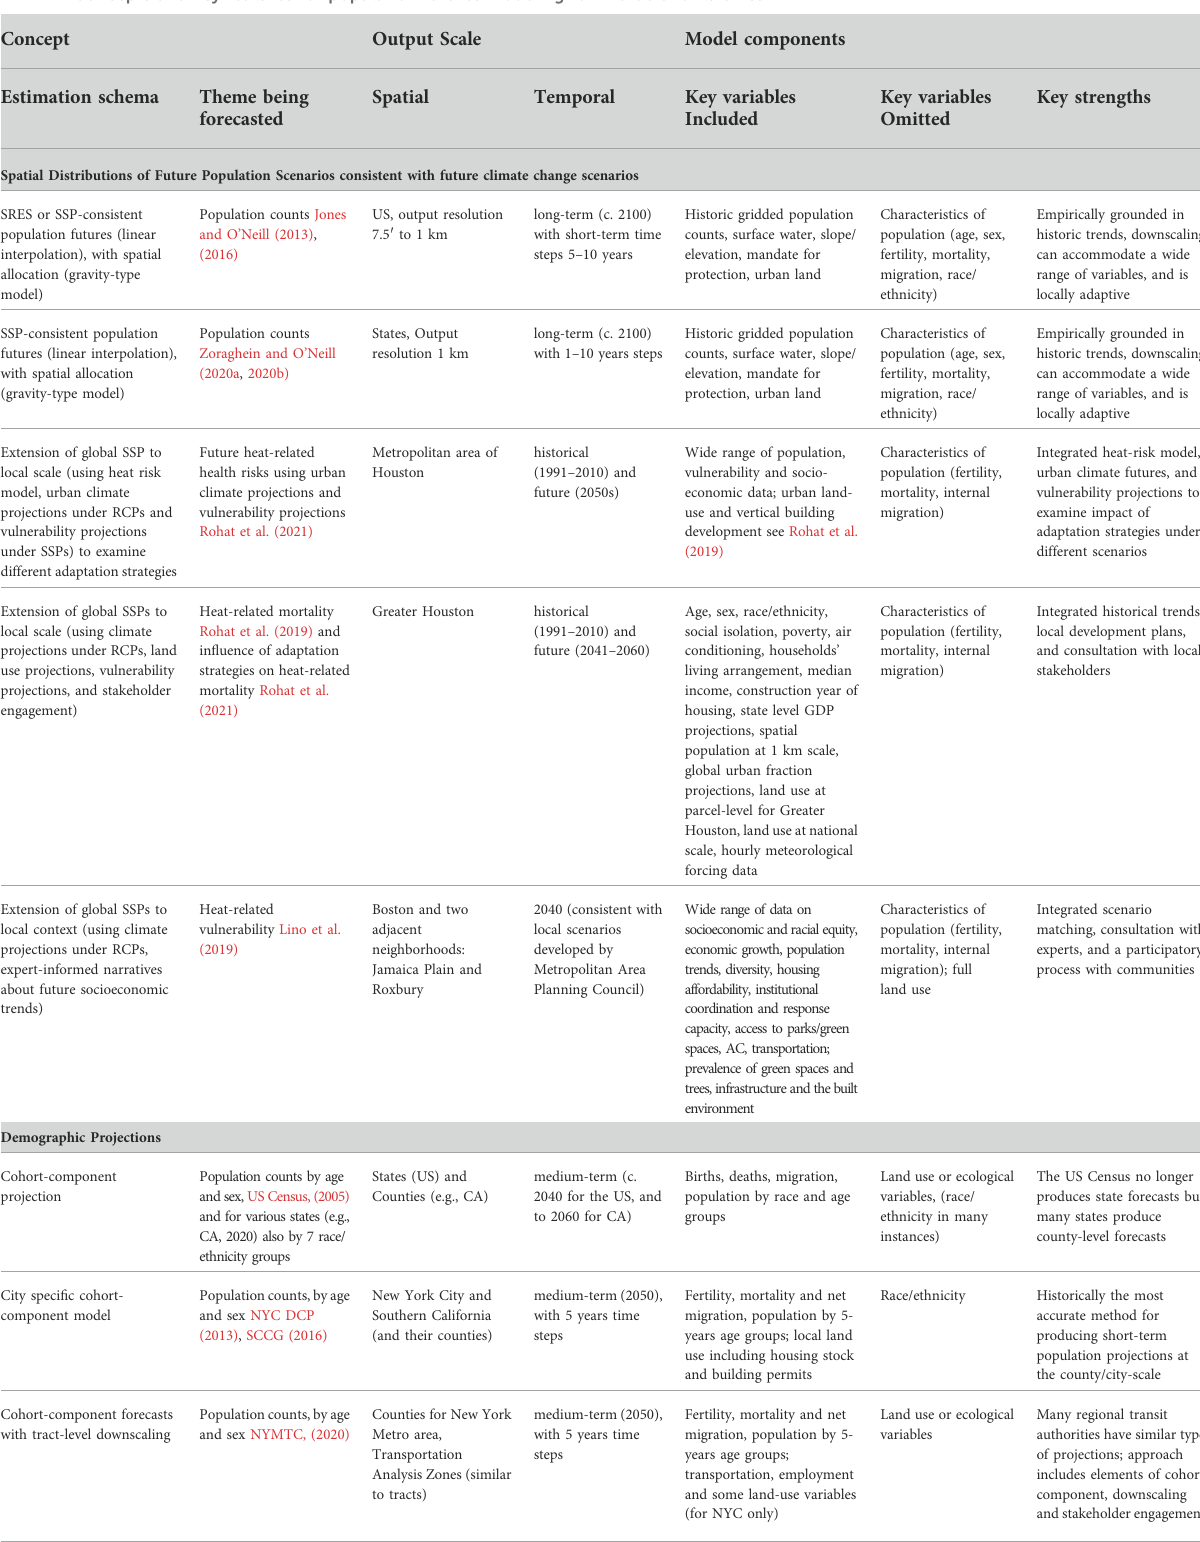
TABLE 1 Concepts and key features for population futures modeling for the US and its